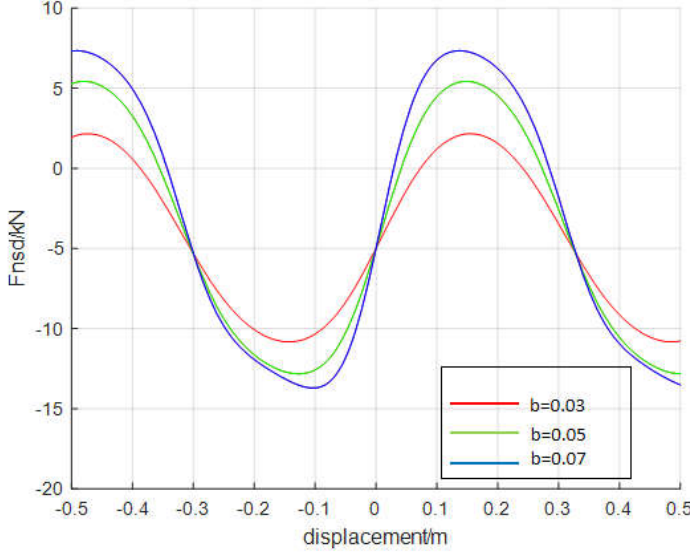
Figure 9. Force–displacement curve under different b values.